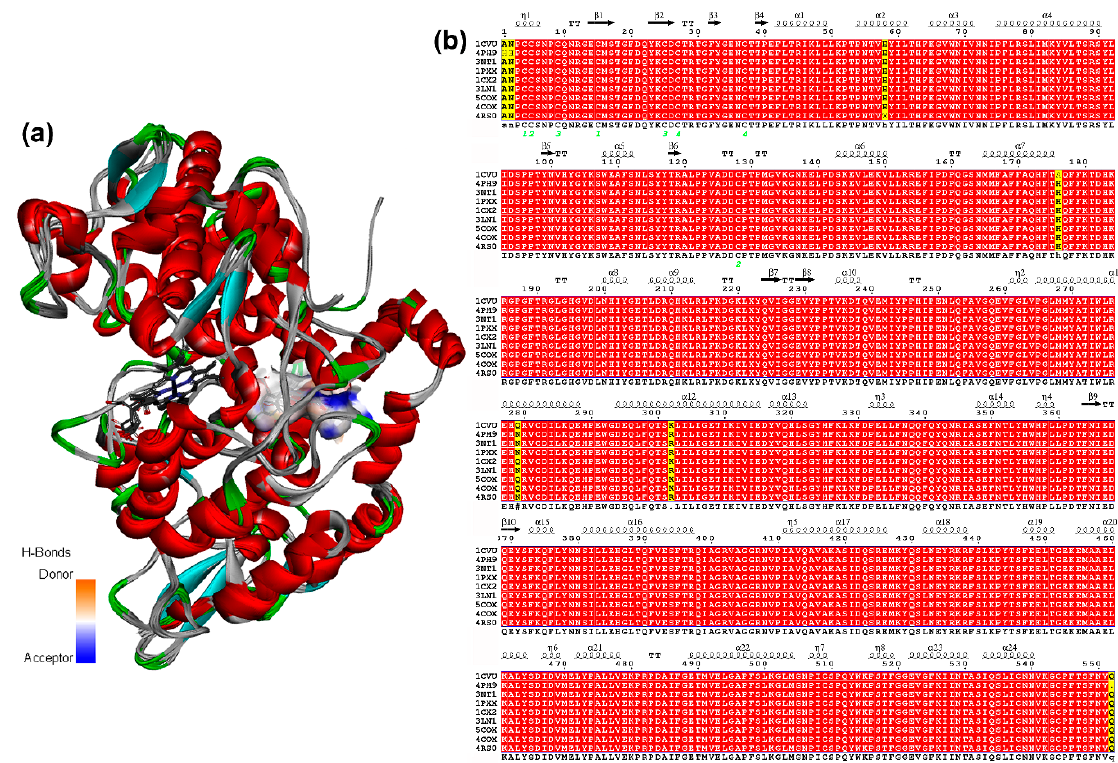
Figure 3. ( a ) Superposition of chains-A from nine COX-2 structures (represented as solid ribbons) after sequence alignment. The active site is highlighted by the H -bond donor/acceptor surface, based on the heatmap (orange = donor, blue = acceptor). The HEME group as grey sticks. ( b ) Sequence alignment chains-A from 9 COX-2 crystal enzymes. The figure was produced using ESPript (http://espript.ibcp.fr). Additionally, docking scores were found to be adequately distributed and reproducible. The relative standard deviation (RSD) percentages resulted in the 2.7%–33.2% range, but only 16.3% of the RSD values were above 10% and 3.6% of the RSD values above 20%. These facts are a good